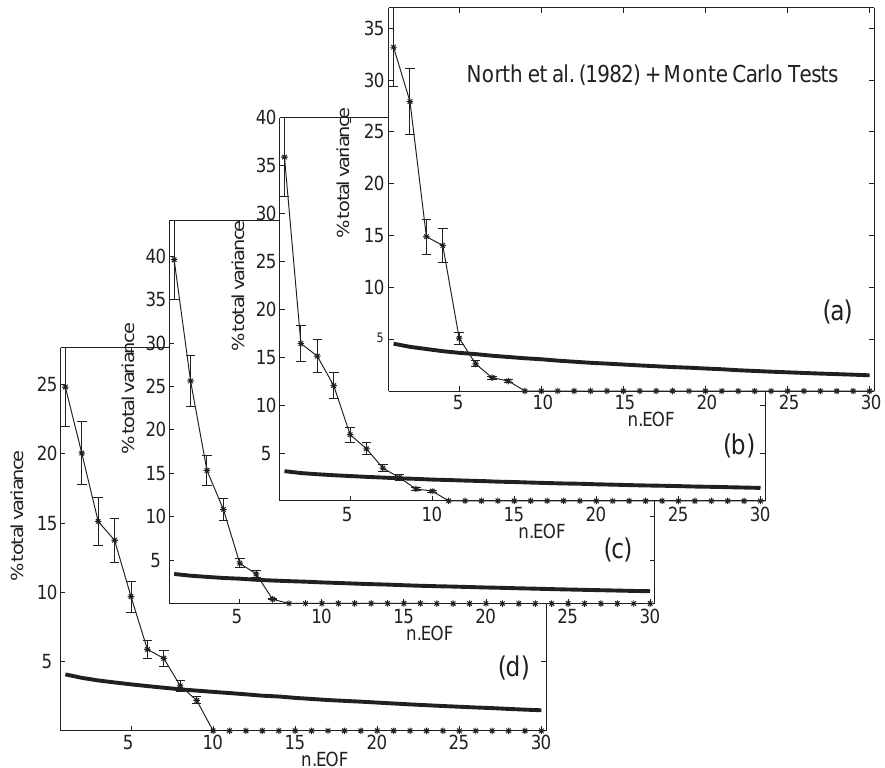
Fig. 4. Percentage of explained variance of the EOF modes for (a) DJF, (b) MAM, (c) JJA and (d) SON. Error bars estimated by North et al. (1982)’s rule of thumb. Thick line indicates the Monte Carlo